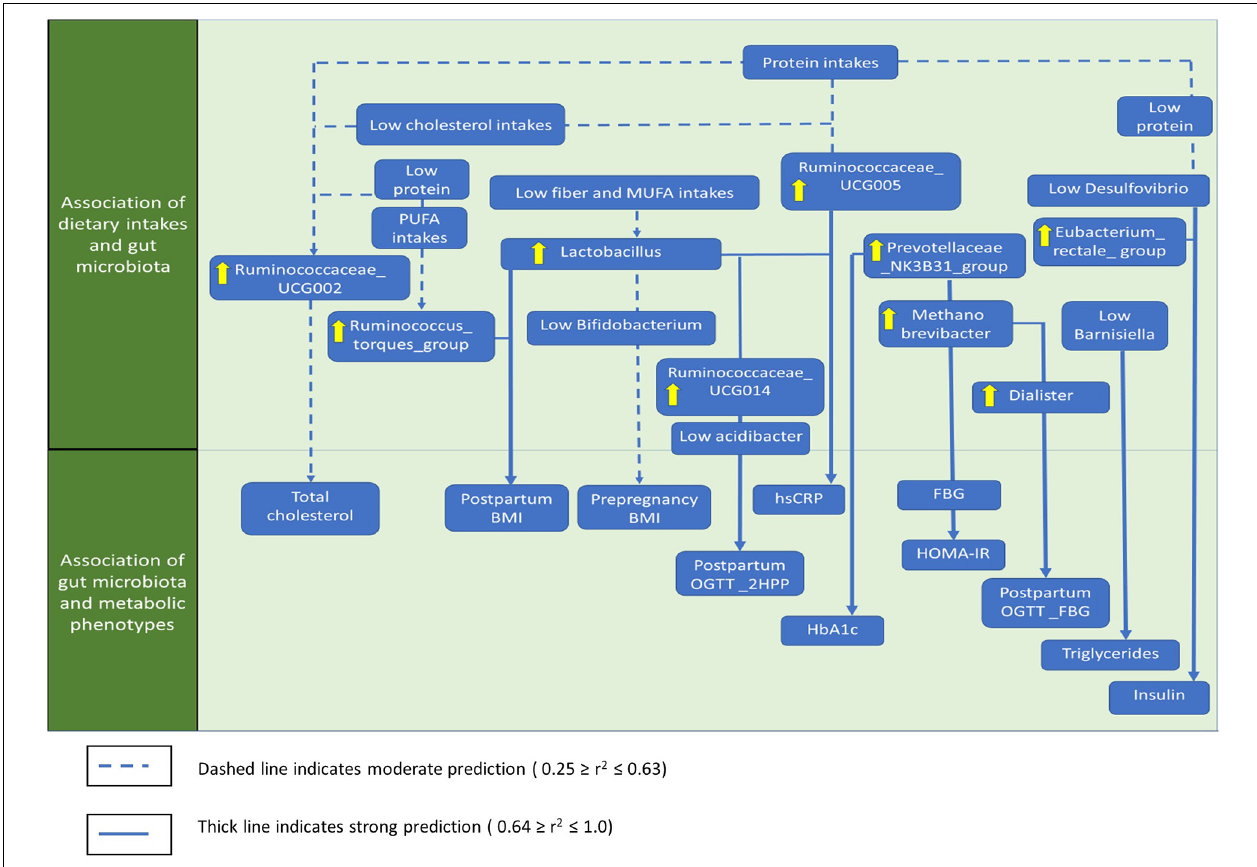
FIGURE 7 | The summary of the genera that significantly associated with macronutrients, anthropometrics, and glycemic control. Only the most significant genera that influence the associations were shown. SAFA, saturated fatty acids; PUFA, polyunsaturated fatty acids; MUFA, monounsaturated fatty acids; BMI, body mass index, WHR, waist to hip ratio; OGTT, oral glucose tolerance test; FBG, fasting blood glucose; 2HPP, 2-h-post prandial blood glucose; HOMA-IR, homeostasis model assessment-estimated insulin resistance; hs-CRP, high-sensitivity C-reactive